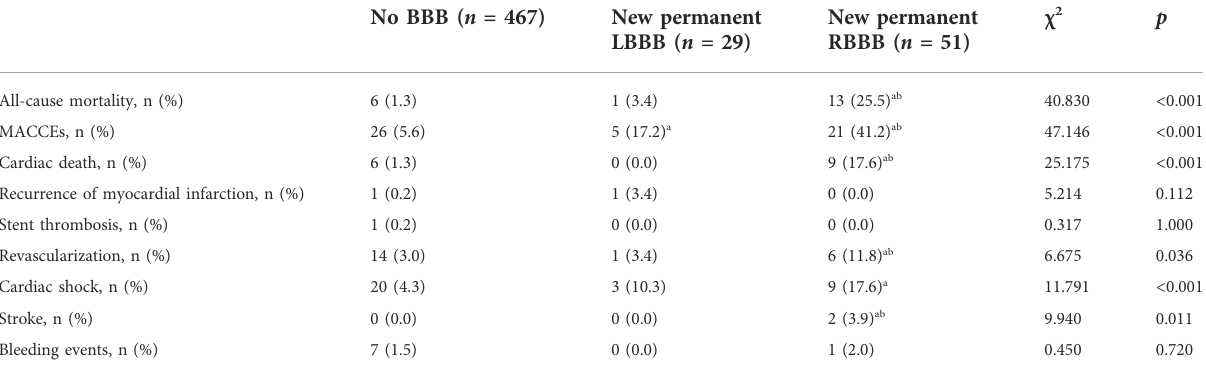
TABLE 2 Incidence of adverse